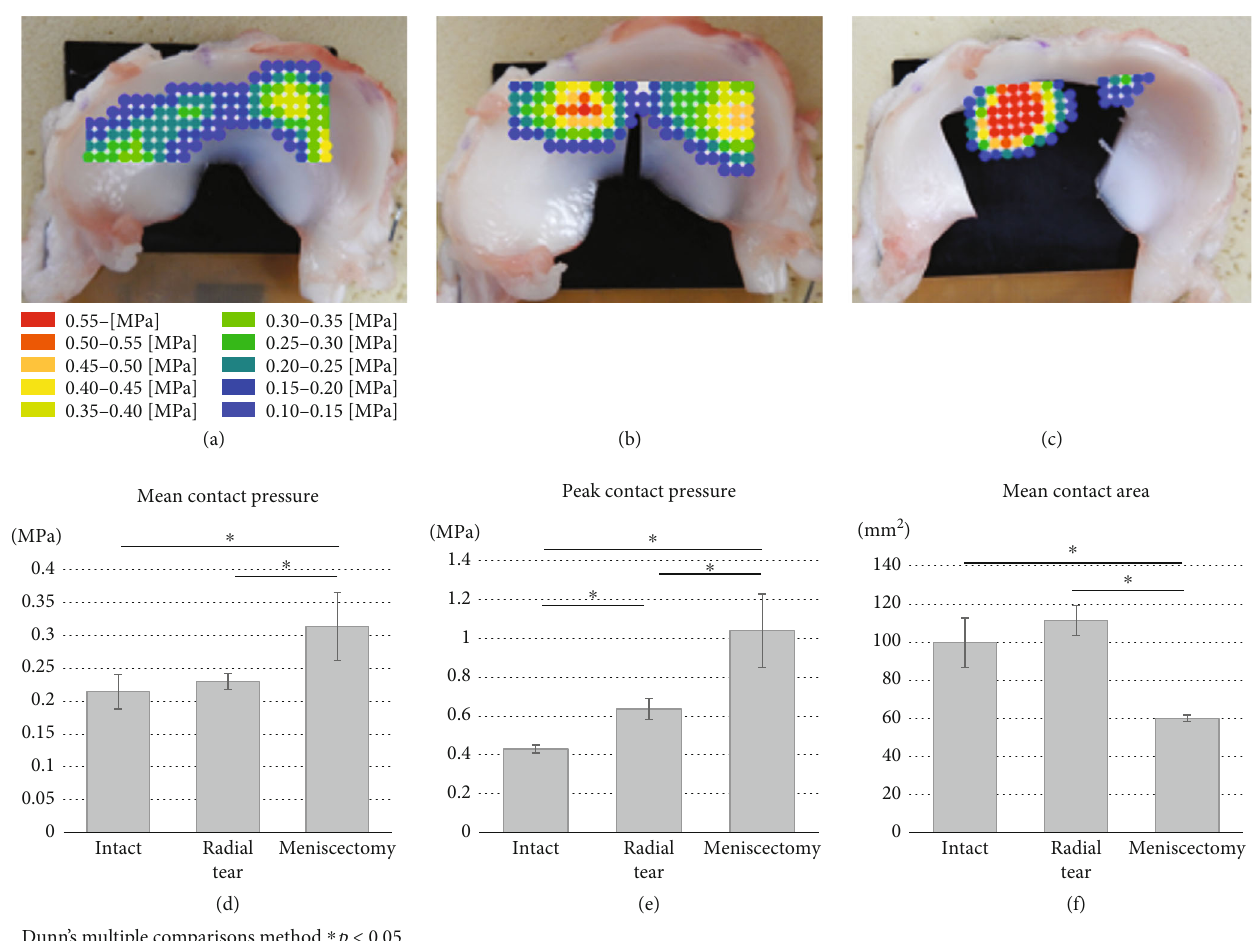
Figure 5: Representative color map of medial meniscal pressure under (a) intact, (b) radial tear extending 90%, and (c) partial meniscectomy involving removal of the central 60%. Calculated results for (d) mean contact pressure, (e) peak contact pressure, and (f) mean contact